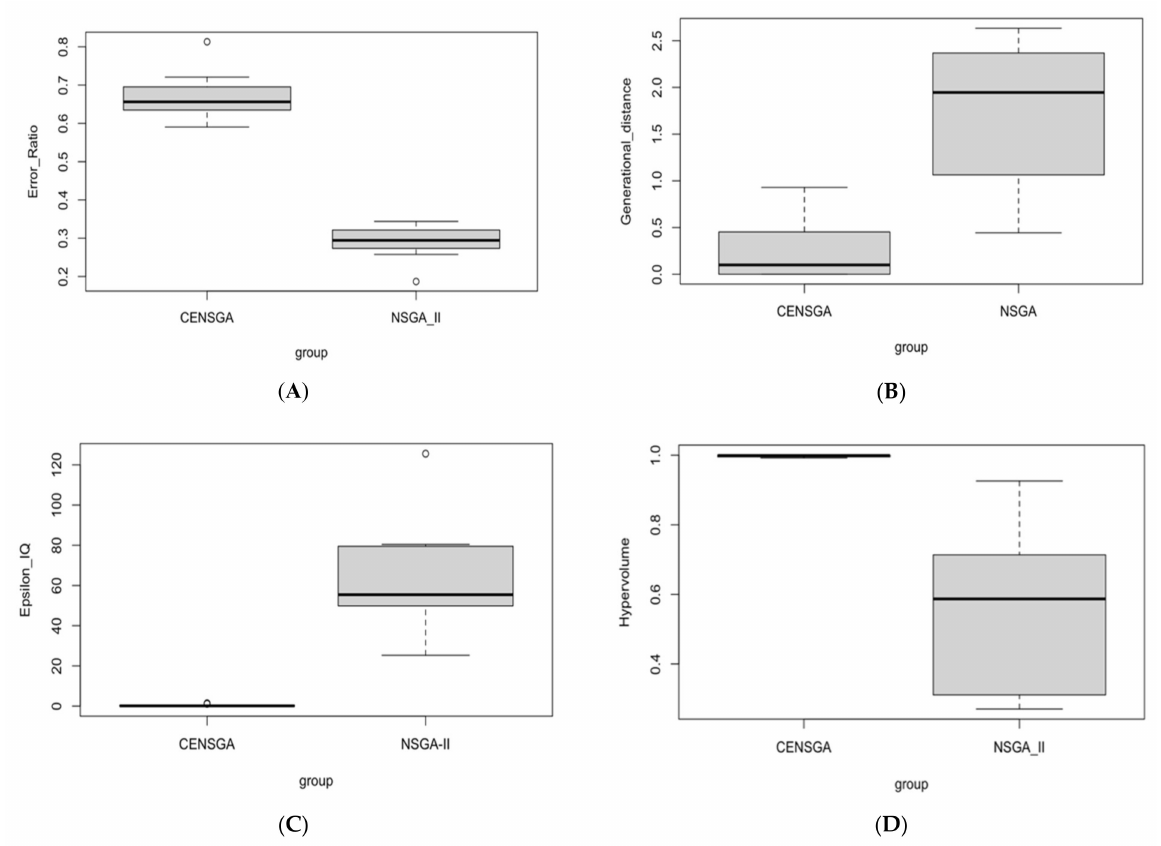
Figure A2. Performance measures of all mean experiment cases. ( A ) Error ratio. ( B ) Generational distance. ( C ) ε -indicator. ( D )